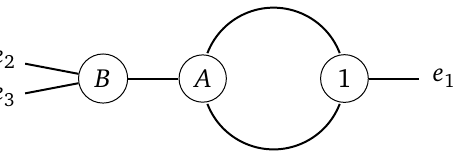
} and tensors i C